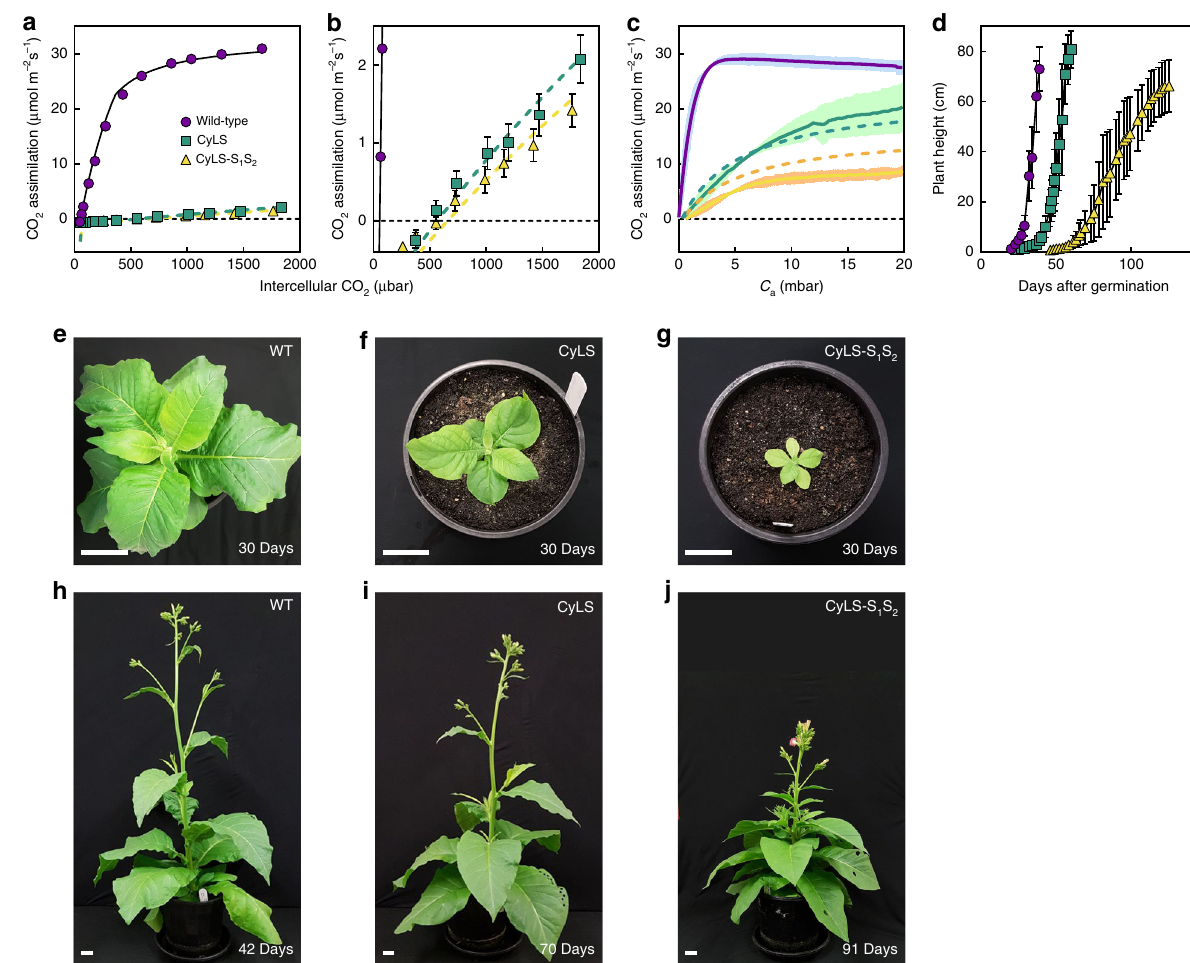
Fig. 5 Form-1A Rubisco-dependent plant growth. CO 2 assimilation rates of wild-type and transgenic tobacco expressing Cyanobium PCC7001 Form-1A Rubisco (CyLS) and expressing Cyanobium Rubisco together with the carboxysome genes csoS1A and csoS2 (CyLS-S 1 S 2 ), determined by gas exchange of attached leaves. Rates are expressed on a leaf area basis ( a ) with an expanded scale for the same data presented in b to show assimilation rates in transformed plants. Data are presented as means ( n = 3-6) ± s.e.m. Fitted lines (WT, black; CyLS, cyan; CyLS-S 1 S 2 , yellow) were calculated as the minimum of modelled Rubisco- and electron transport-limited rates of CO 2 assimilation according to Farquhar et al. 64 using the Rubisco catalytic parameters presented in Table 2, and a J max of 140 µ mol m − 2 s − 1 , at 25 °C. The model predicts Rubisco active site concentrations of 1.8 ± 0.4 (s.e.m.) and 1.7 ± 0.4 (s.e. m.) µ mol sites m − 2 for CyLS and CyLS-S 1 S 2 leaves, respectively, within the range determined from leaf tissue (Table 2). Equations are outlined in Methods. c CO 2 assimilation rates of leaf discs from each plant line from plants grown at 2% ( v / v ) CO 2 in membrane inlet mass spectrometer (MIMS) assays, carried out as described in Methods. Solid lines (WT, magenta; CyLS, cyan; CyLS-S 1 S 2 , yellow) are averaged data from n = 3 independent leaf discs (±s.d., shaded areas). The dashed lines for CyLS and CyLS-S 1 S 2 are modelled assimilation rates using the same parameters as a , b . Using the model to estimate − 1 ± 0.01 (s.e.m.) based on the measured Rubisco content in Table 2. d Growth k cat for the Rubisco in CyLS-S 1 S 2 leaf discs gives an estimate of 6.46 s measured as plant height post germination (±s.e.m., n = 4-6) for wild-type, CyLS and CyLS-S 1 S 2 plants grown at 2% ( v / v ) CO 2 . Growth phenotypes at 30 days after germination ( e – g ) and at maturity ( h – j ) of wild-type ( e , h ), CyLS ( f , i ) and CyLS-S 1 S 2 ( g , j ) plants grown in soil at 2% ( v / v ) CO 2 in 20 cm pots. Note the delayed germination and time to reach maturity in both transformant lines. Scale bars 5